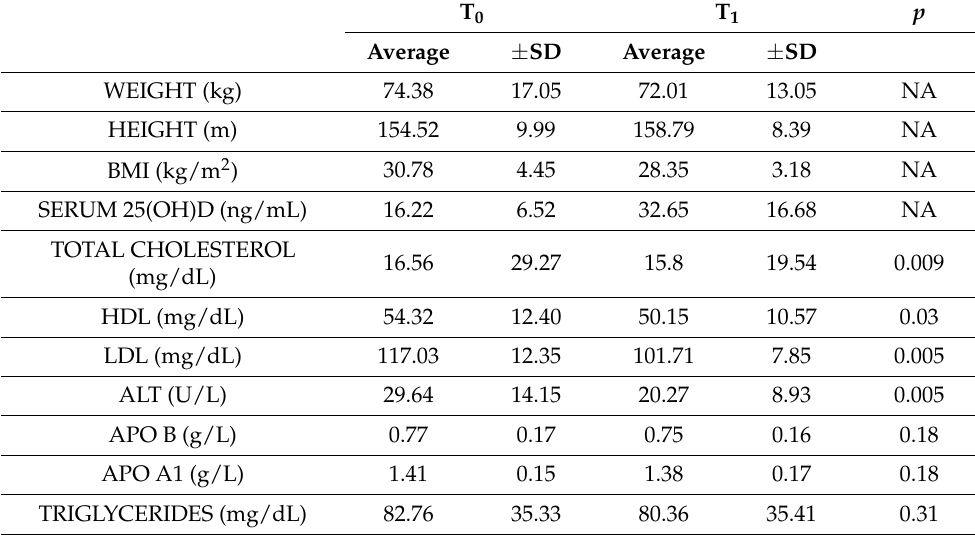
Table 1. Average and standard deviations (SDs) of anthropometric and laboratory parameters before and after vitamin D